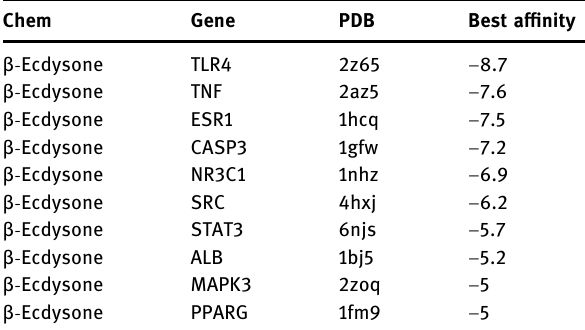
Table 3: Molecular docking results